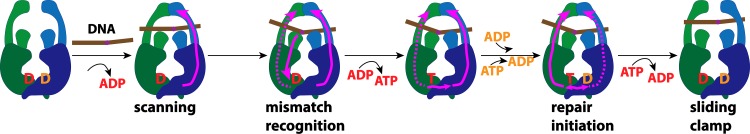
A proposed mechanism of how switched communication paths with alternate nucleotide-bound states facilitates mismatch repair initiation.